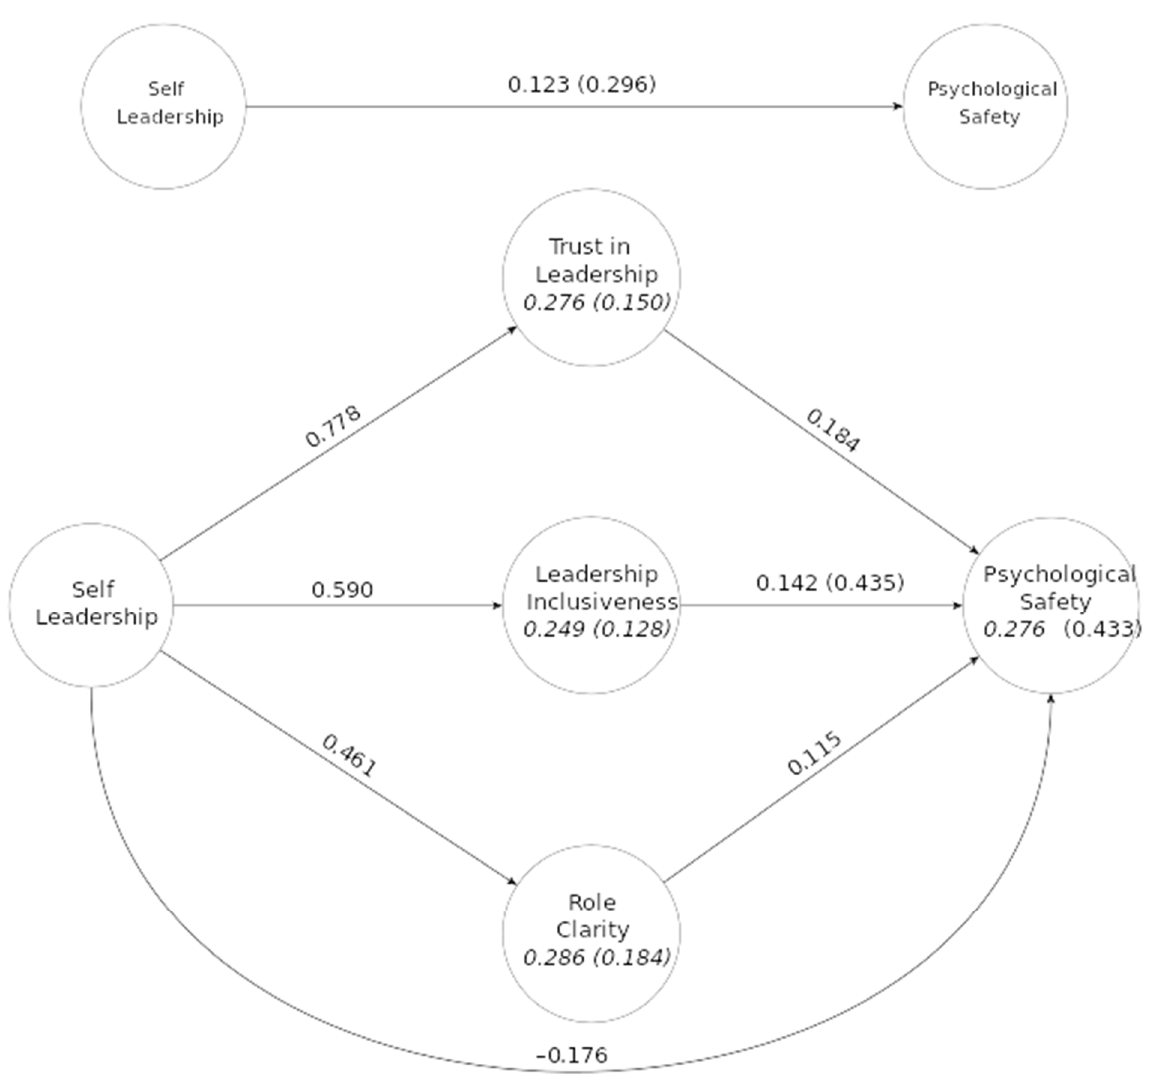
Figure 3. Model results for follower self-leadership influences on follower psychological